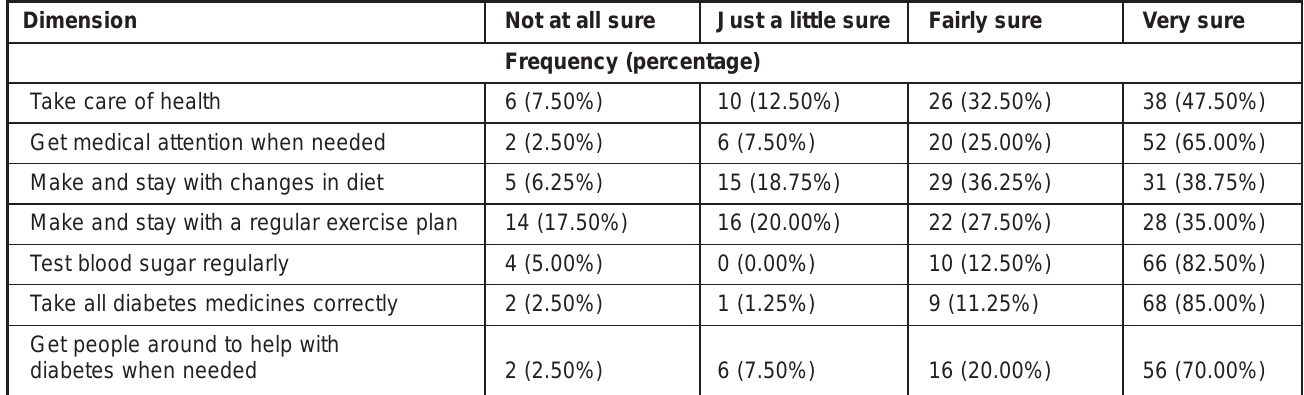
Table 3: Distribution of self-efficacy score per IDEALL question by Likert category (n= 80)